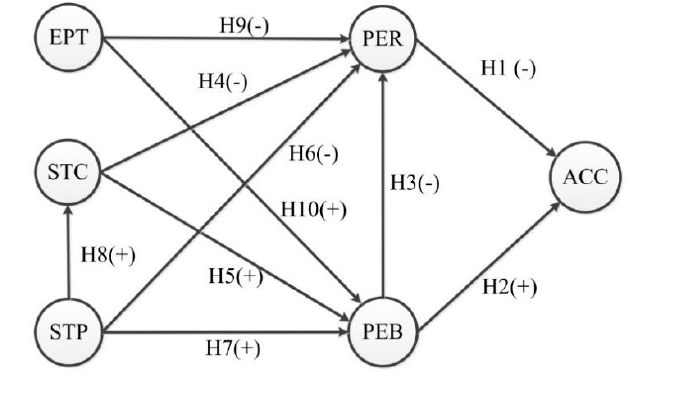
Figure 1. The concept model.